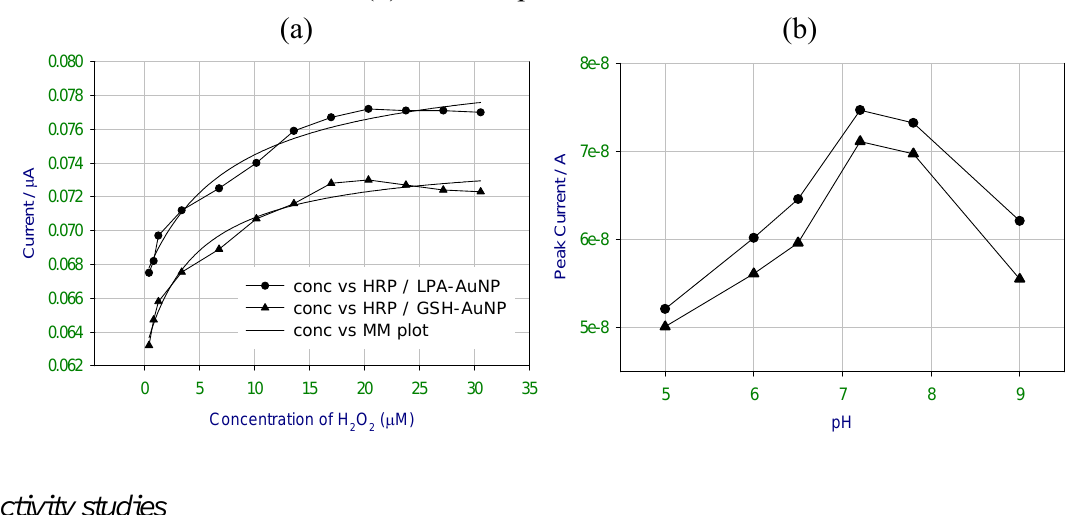
Figure 7. Dependence of the peak current values obtained from cyclic voltammogram of HRP coupled to lipoic acid capped (- ● -) measured at the potential of 0.06 V and glutathione capped AuNP (- ▲ -) measured at a potential 0.01 V using (a) different O and at (b) different concentrations of H 2 2